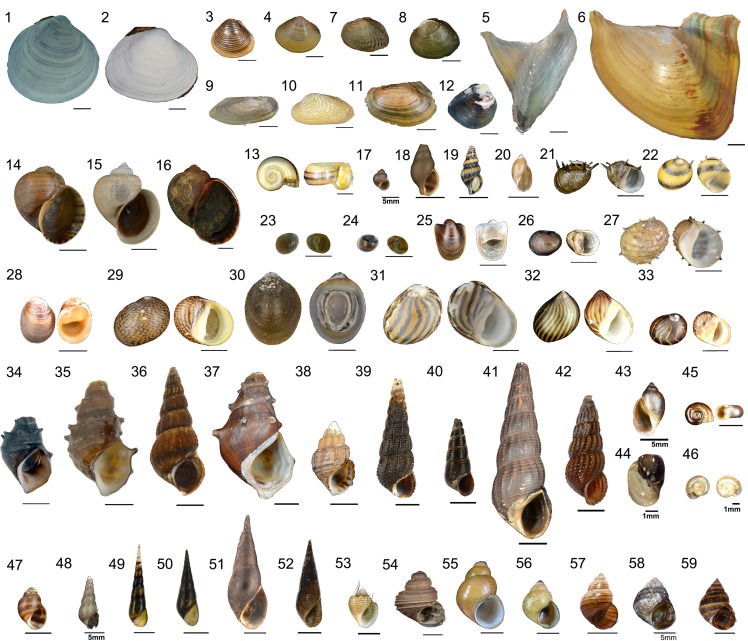
Freshwater molluscs in the ornamental pet trade.Unless indicated differently, scale bars = 10mm. 1. Batissa similis; 2. Batissa violacea; 3. Corbicula fluminea; 4. Corbicula moltkiana; 5. Hyriopsis bialata; 6. Hyriopsis desowitzi; 7. Parreysia burmana; 8. Parreysia tavoyensis; 9. Pilsbryoconcha exilis; 10. Scabies crispata; 11. Sinanodonta woodiana; 12. Unionetta fabagina; 13. Marisa cornuarietis; 14. Pomacea canaliculata; 15. Pomacea diffusa; 16. Pomacea maculata (photograph by K.A. Hayes); 17. Bithynia sp.; 18. Clea bockii; 19. Clea helena; 20. Radix rubiginosa; 21. Clithon corona; 22. Clithon diadema; 23. Clithon lentiginosum; 24. Clithon mertoniana; 25. Neripteron auriculata; 26. Neritina iris; 27. Neritina juttingae; 28. Neritina violacea; 29. Neritodryas cornea; 30. Septaria porcellana; 31. Vittina coromandeliana; 32. Vittina turrita; 33. Vittina waigiensis; 34. Brotia armata; 35. Brotia binodosa; 36. Brotia herculea; 37. Brotia pagodula; 38. Sulcospira tonkiniana; 39. Tylomelania towutica; 40. Tylomelania sp.; 41. Tylomelania sp.; 42. Tylomelania sp.; 43. Physa sp.; 44. Amerianna carinata; 45. Indoplanorbis exustus; 46. Gyraulus convexiusculus; 47. Semisulcospira sp.; 48. Melanoides tuberculata; 49. Stenomelania offachiensis; 50. Stenomelania plicaria; 51. Stenomelania cf. plicaria; 52. Stenomelania sp.; 53. Thiara cancellata; 54. Celetaia persculpta; 55. Filopaludina cambodjensis; 56. Filopaludina peninsularis; 57. Filopaludina polygramma; 58. Sinotaia guangdungensis; 59. Taia pseudoshanensis.